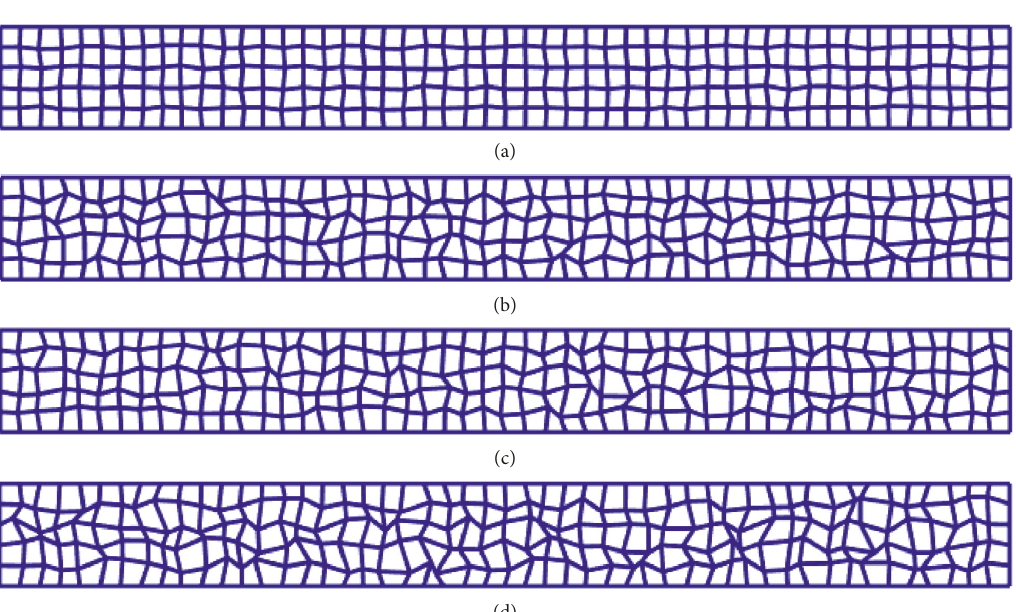
� 0 . 1. (b) α � 0 . 2. (c) α � 0 . 3. (d) α � 0 . 4. r r r r